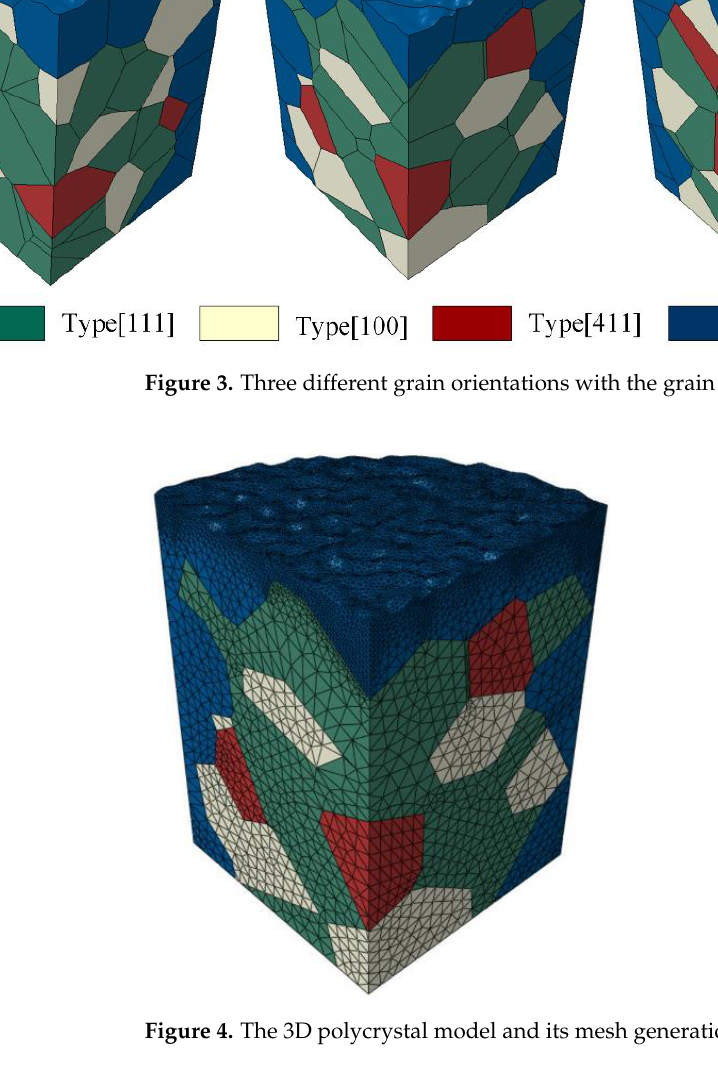
Figure 4. The 3D polycrystal model and its mesh generation.